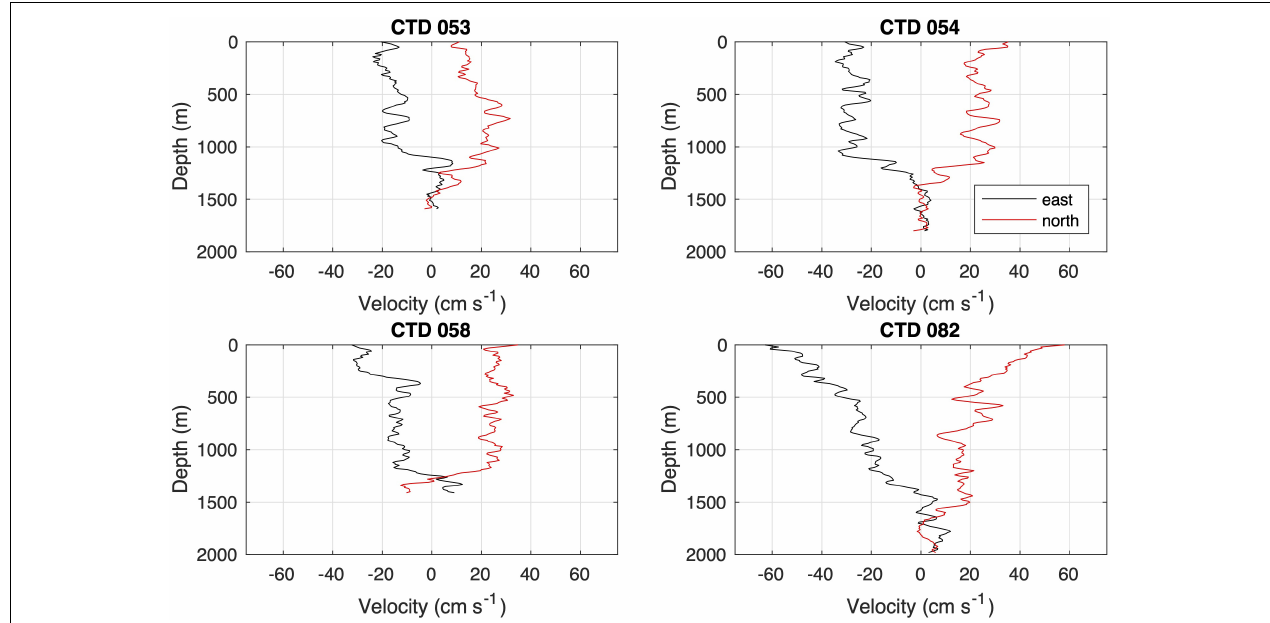
FIGURE 7 | In situ currents from lowered ADCP at Brothers. Black denotes east-west velocity (positive to the east), red denotes north-south velocity (positive to the north). CTD 082 was conducted at the same location and on the same day as TMR 083.